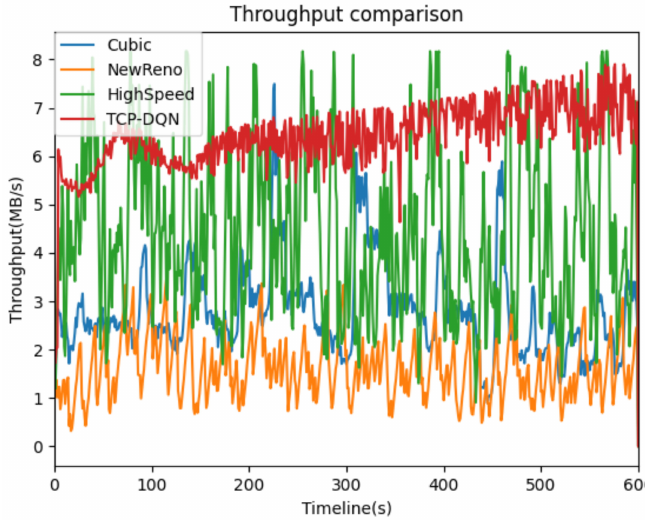
Figure 4. Throughput performance comparison.